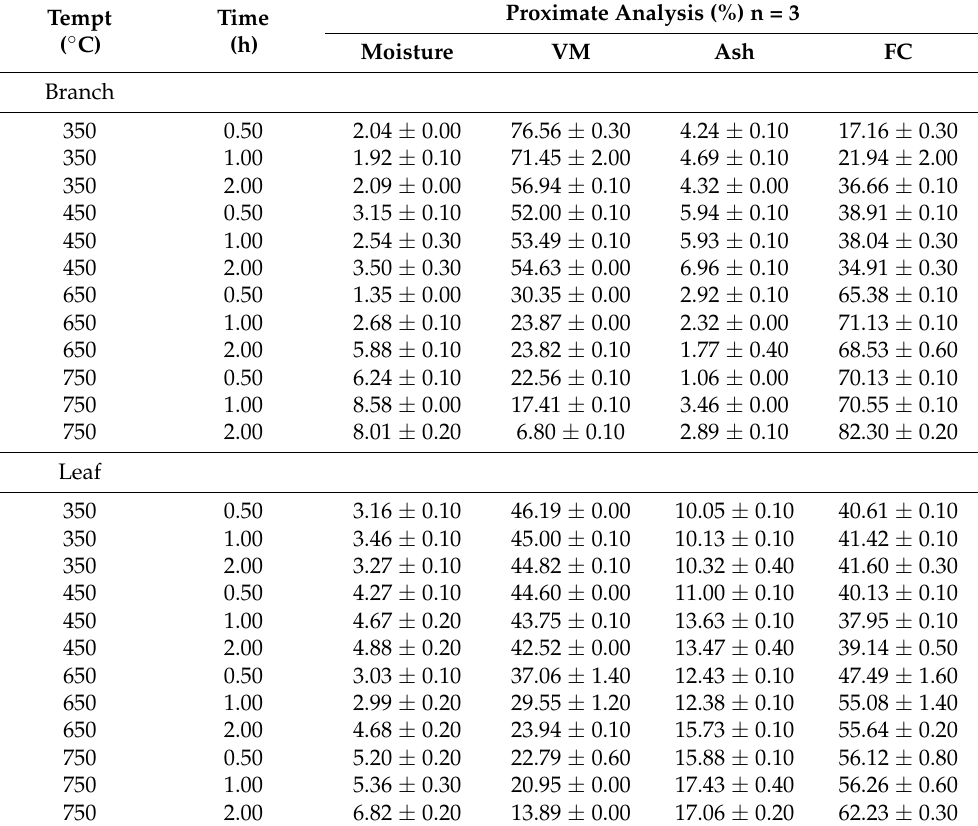
Table 2. Proximate analysis for all